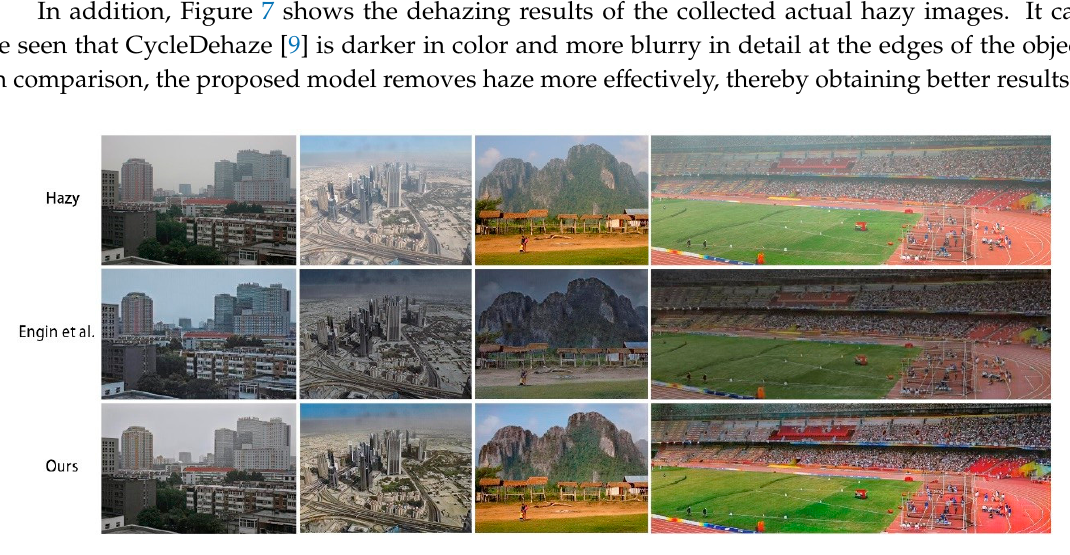
Figure 7. Qualitative results using natural hazy images in comparison with those generated by CycleDehaze [9]. Sensors 2020 , 20 , x FOR PEER REVIEW